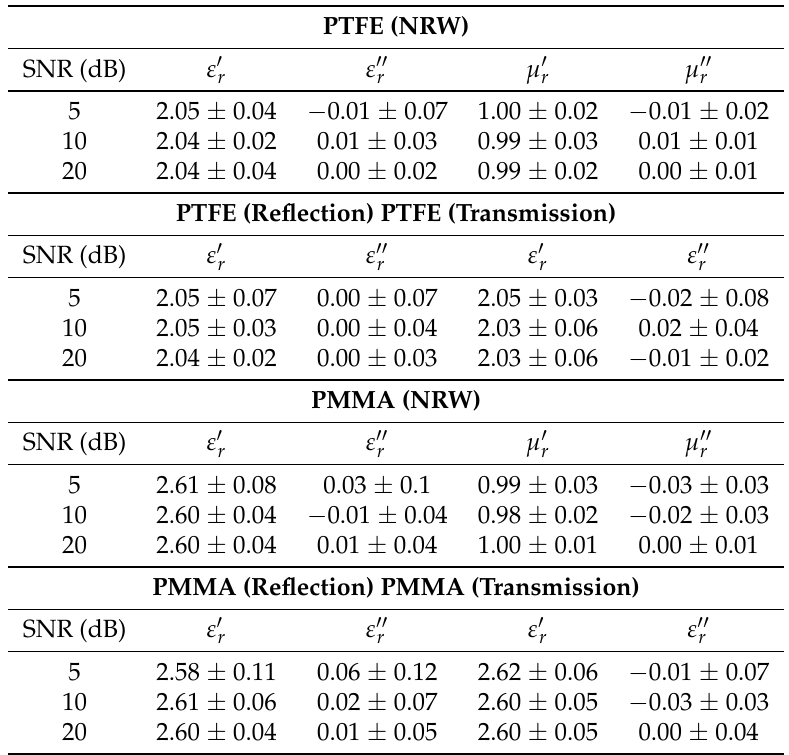
Table 1. Over the frequency average and standard deviation of the extracted properties for the simulated materials, using the frequency-by-frequency approaches with different SNR.